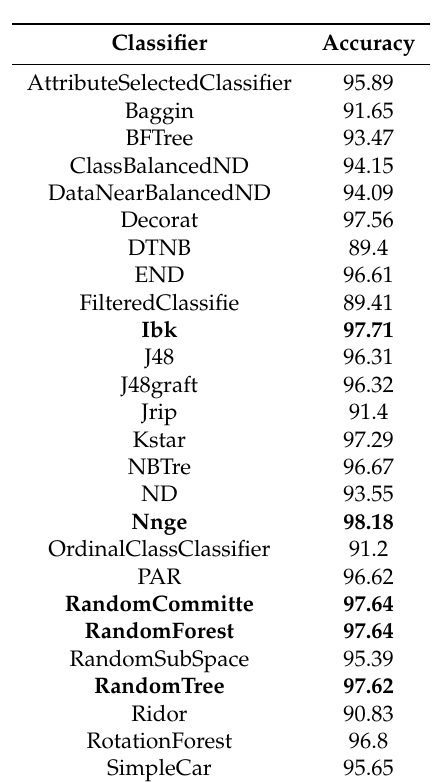
Table 4. Accuracy obtained by the top 12